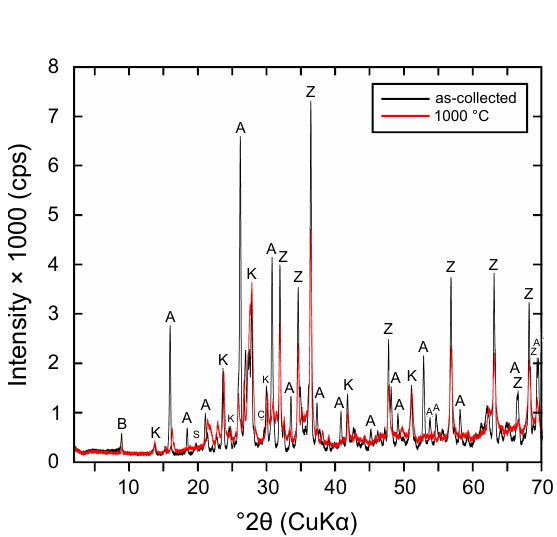
Figure 11: X-ray powder di ff raction (XRPD) profile for a sample of “as collected” (i.e. material that has undergone no heating or deformation) Mt. Epomeo Green Tu ff (MEGT) and a sample of MEGT exposed to 1000 ◦ C. Z – ZnO; B – biotite; A – analcime; S – smec- tite; C – calcite; K – K-feldspar.